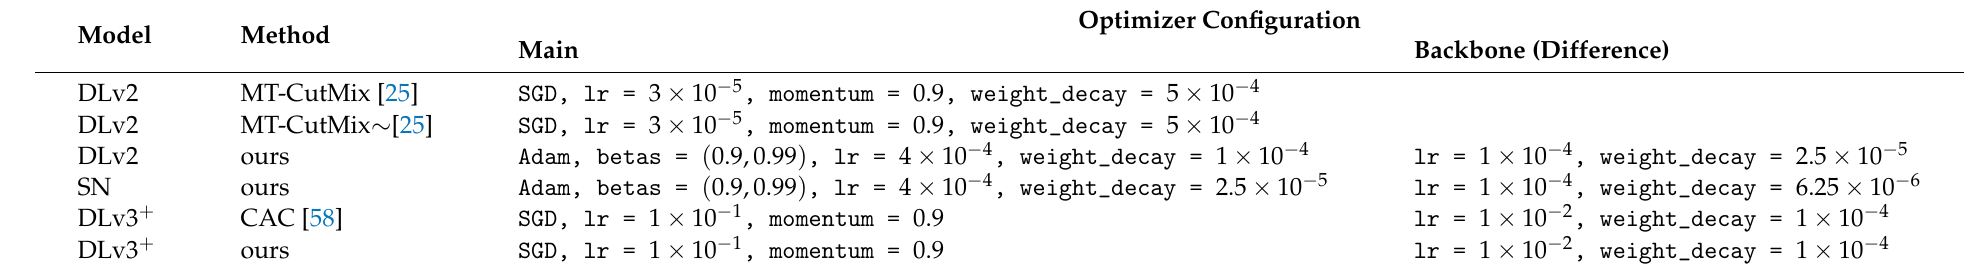
Table A2. Optimizer hyper-parameter configurations for Cityscapes semantic segmentation experiments, represented in a PyTorch-like